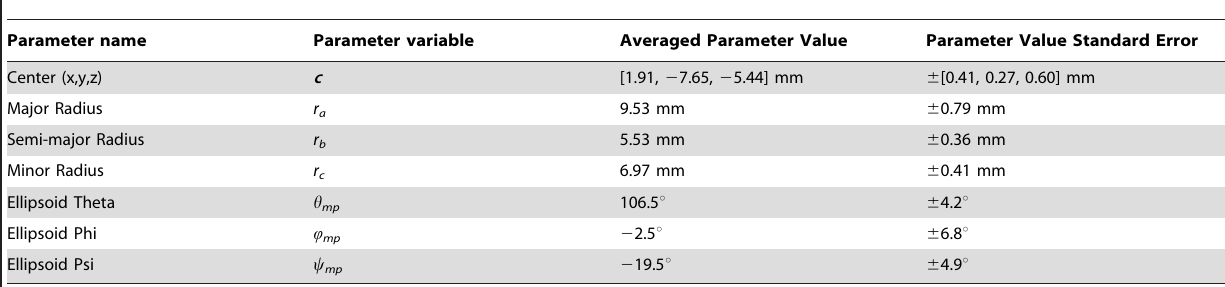
Table 2. Mystacial pad ellipsoid parameter